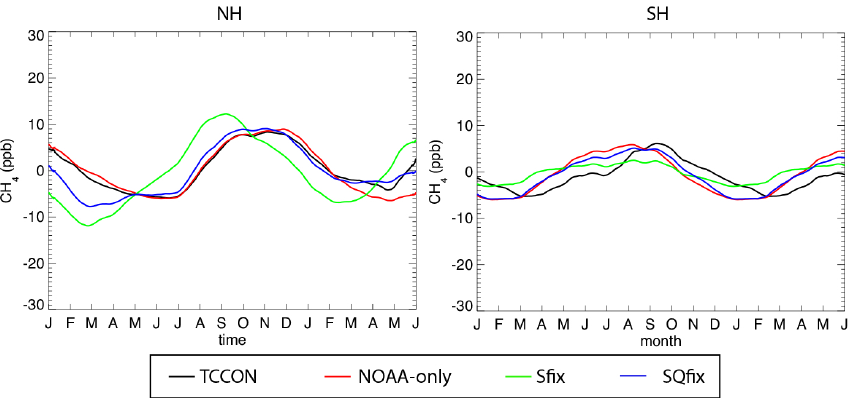
Fig. 4. Comparisons between detrended TCCON and inversion-derived seasonal cycles of X CH 4 averaged over TCCON sites in the Northern Hemisphere (left) and Southern Hemisphere (right). Black: TCCON, red: NOAA only, green: S fix corrected SCIAMACHY, blue: SQ fix corrected